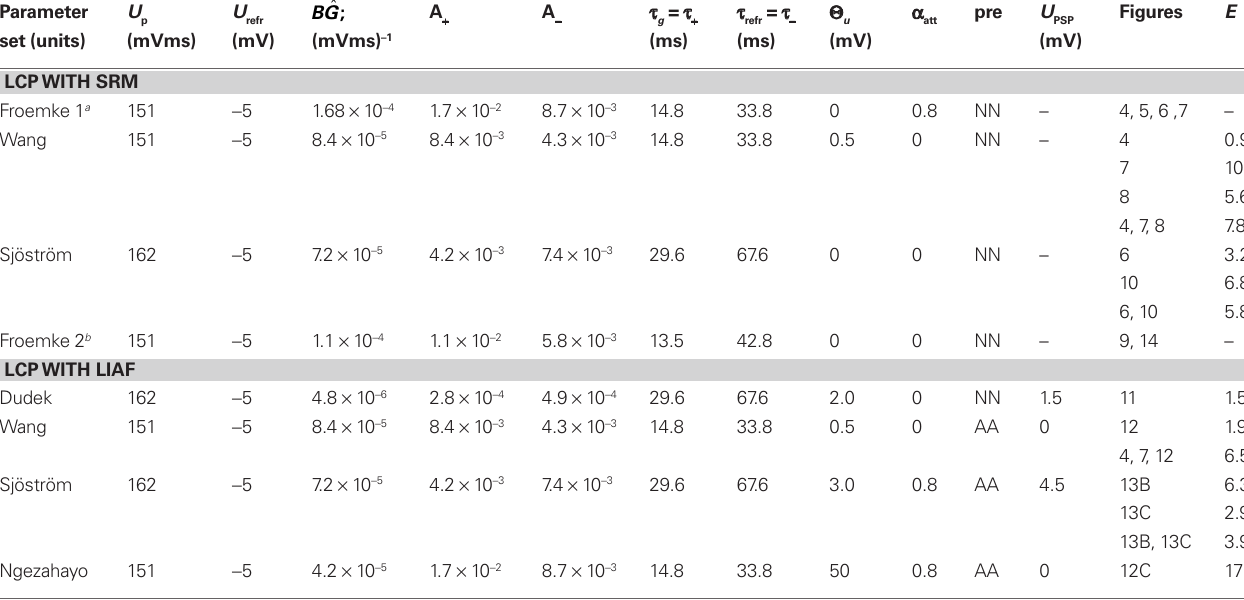
Table 4 | Parameters used for experiment reproduction. Normalized errors ( E ) are given for all experiments for which data points with standard errors were available. If several Figure numbers are given in a row, the corresponding normalized error is calculated over all experiments in the Figures for the parameter set in the row (which may deviate from the parameter set used in the Figures).